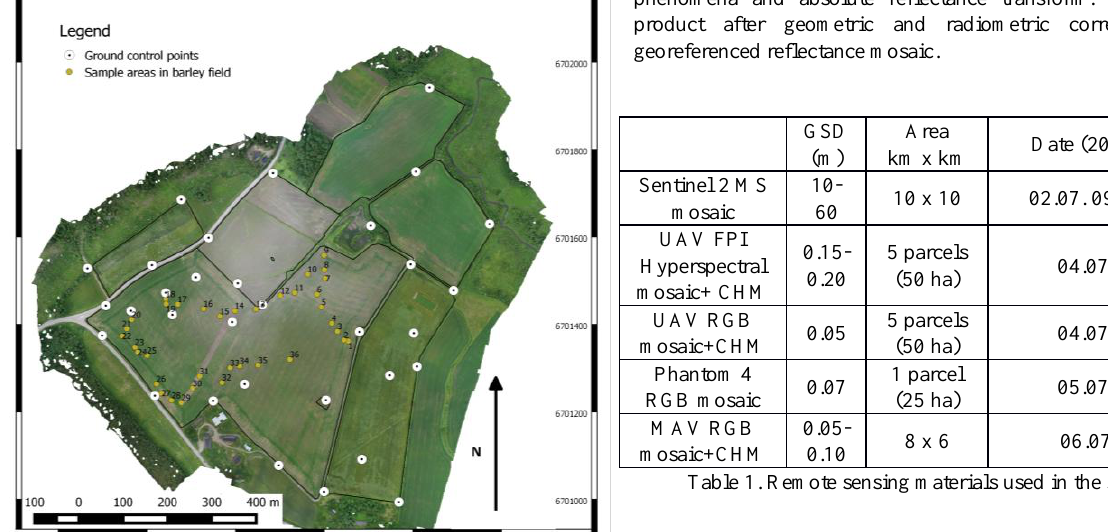
Figure 1. Test site with ground control points and sample areas in barley field. The background image is orthomosaic based on RGB image from drone.